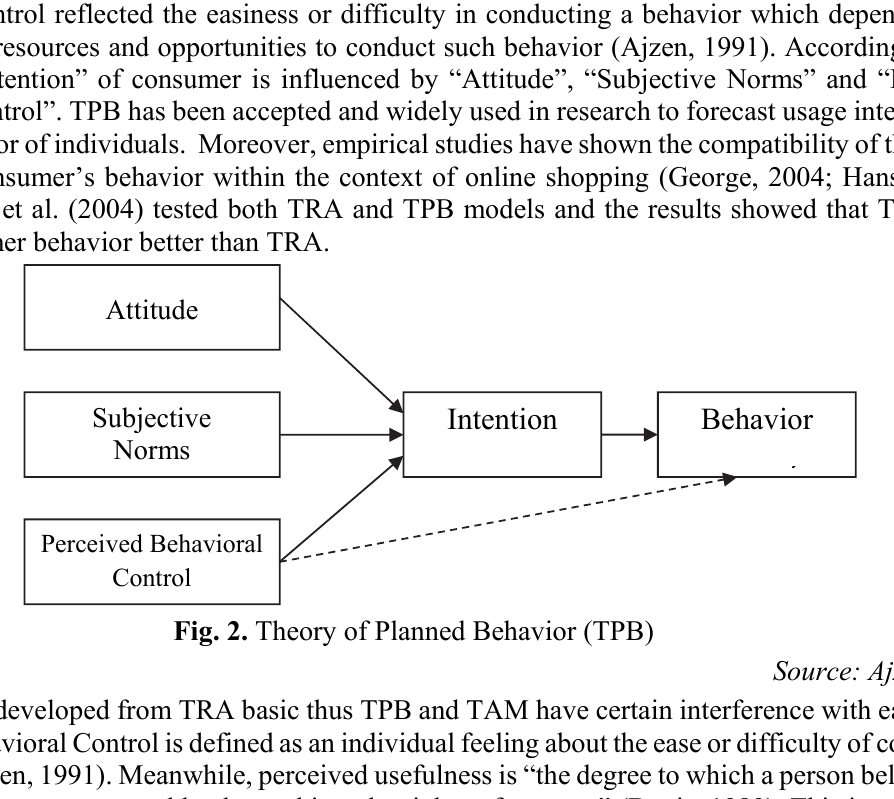
Source: Davis et al., 1989